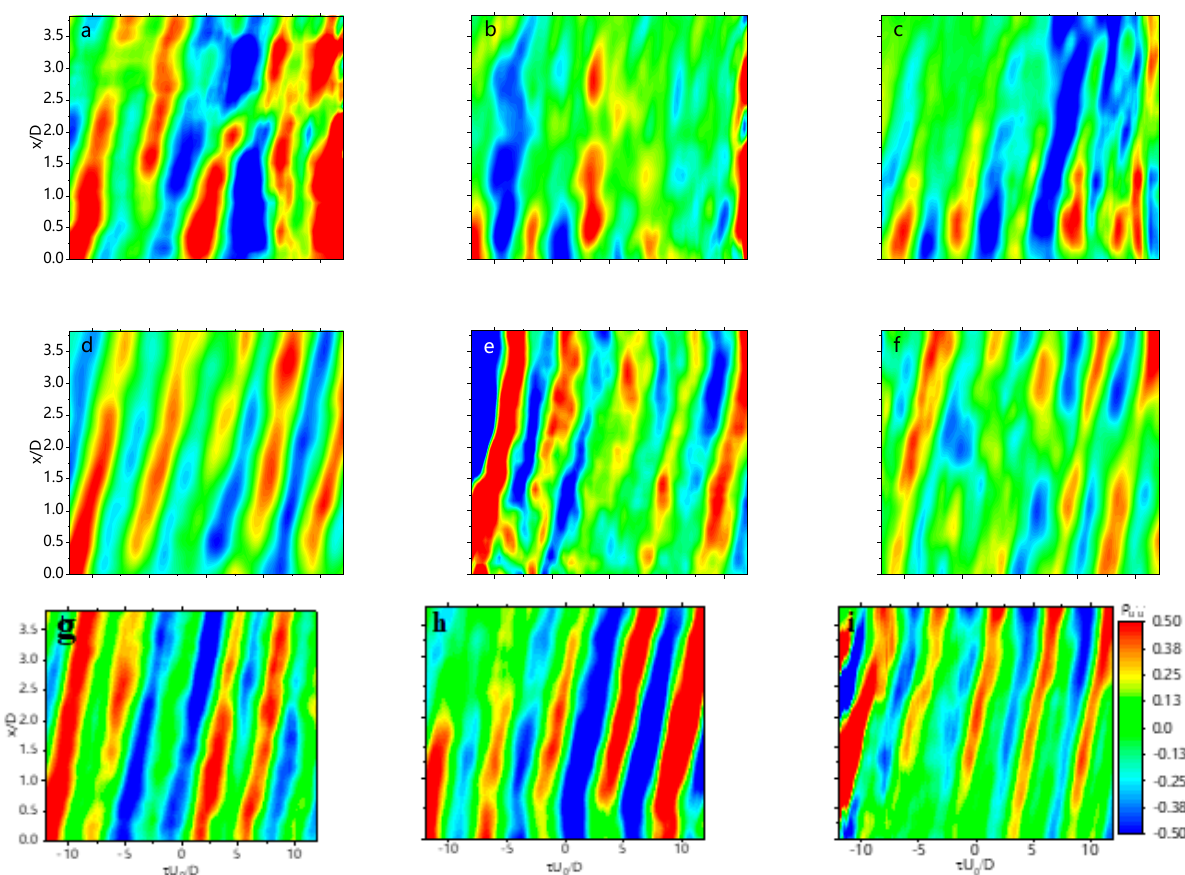
Figure 7. Space–time contour plots of streamwise velocity: ( a ) Ar = 0.2, Re = 1000; ( b ) Ar = 0.3, Re = 1000; ( c ) Ar = 0.5, Re = 1000; ( d ) Ar = 0.2, Re = 2000; ( e ) Ar = 0.3, Re = 2000; ( f ) Ar = 0.5, Re = 2000; ( g ) Ar = 0.2, Re = 5000; ( h ) Ar = 0.3, Re = 5000; ( i ) Ar = 0.5, Re = 5000.